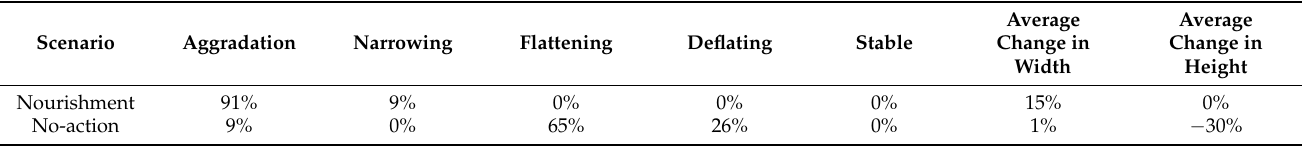
Table 2. Barrier island behaviors and the average change in subaerial island width and maximum island height for the nourishment and no-action scenarios east of Katrina Cut at Dauphin Island,